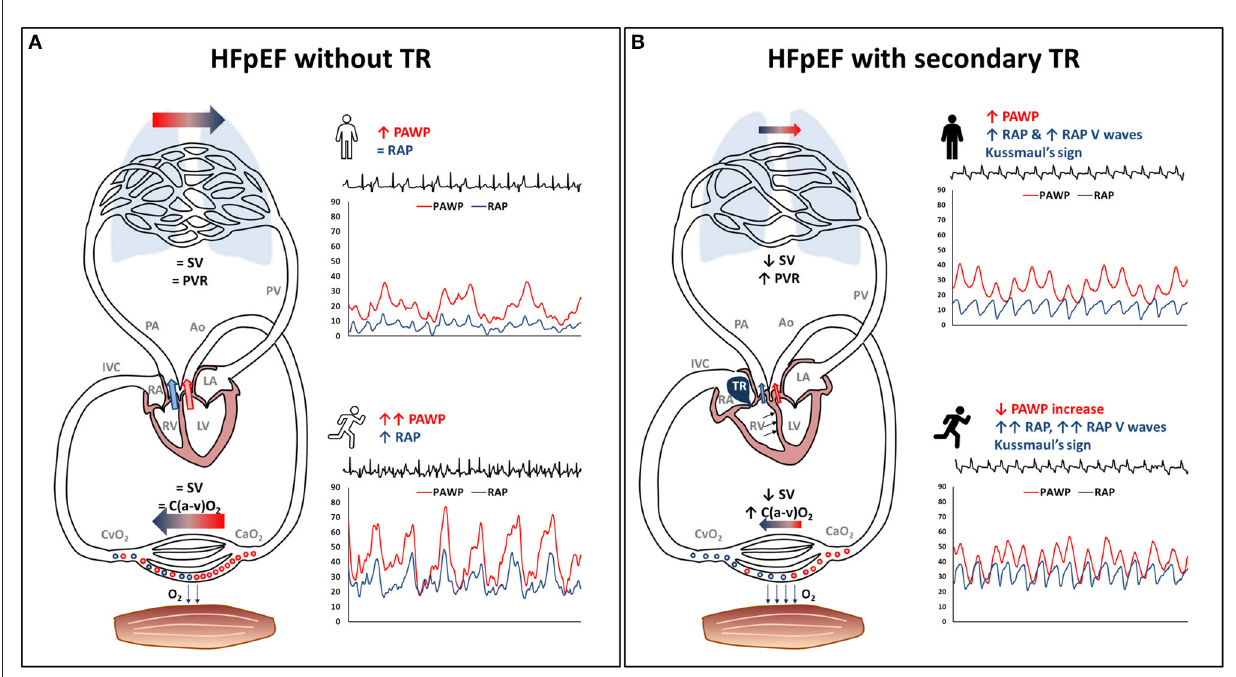
FIGURE4 Exercise pathophysiology of secondary tricuspid regurgitation (STR) in heart failure with preserved ejection fraction (HFpEF). The typical HFpEF patient without STR (panel on the left) may present with (A) high pulmonary artery wedge pressure, either at rest or during exercise, with a steep pulmonary artery wedge pressure rise, and mildly increased right atrial pressure. (B) substantially normal stroke volume, pulmonary vascular resistance and peripheral oxygen extraction. This HFpEF pathophysiology is altered in the presence of STR (panel on the right), being characterized by: (i) high right atrial pressure that lacks inspiratory decrease or may present with overt Kussmaul’s sign, tall V waves in the right atrium, right atrial enlargement and venous congestion; (ii) reduced forward stroke volume with pulmonary vascular derecruitment (increasing pulmonary vascular resistance), left ventricular underfilling, flatter pulmonary artery wedge pressure rise during exercise, and high ratio between right atrial pressure and pulmonary artery wedge pressure; (iii) higher reliance upon peripheral oxygen extraction to exercise despite low stroke volumeAo, aorta; C(a-v)O2, arteriovenous oxygen difference; CaO2, arterial oxygen content; CvO2, venous oxygen content; IVC, inferior vena cava; LA, left atrium; LV, left ventricle; O 2 , oxygen; PA, pulmonary artery; PAWP, pulmonary artery wedge pressure; PV, pulmonary vein; PVR, pulmonary vascular resistance; RAP, right atrial pressure; SV, stroke volume; TR, tricuspid